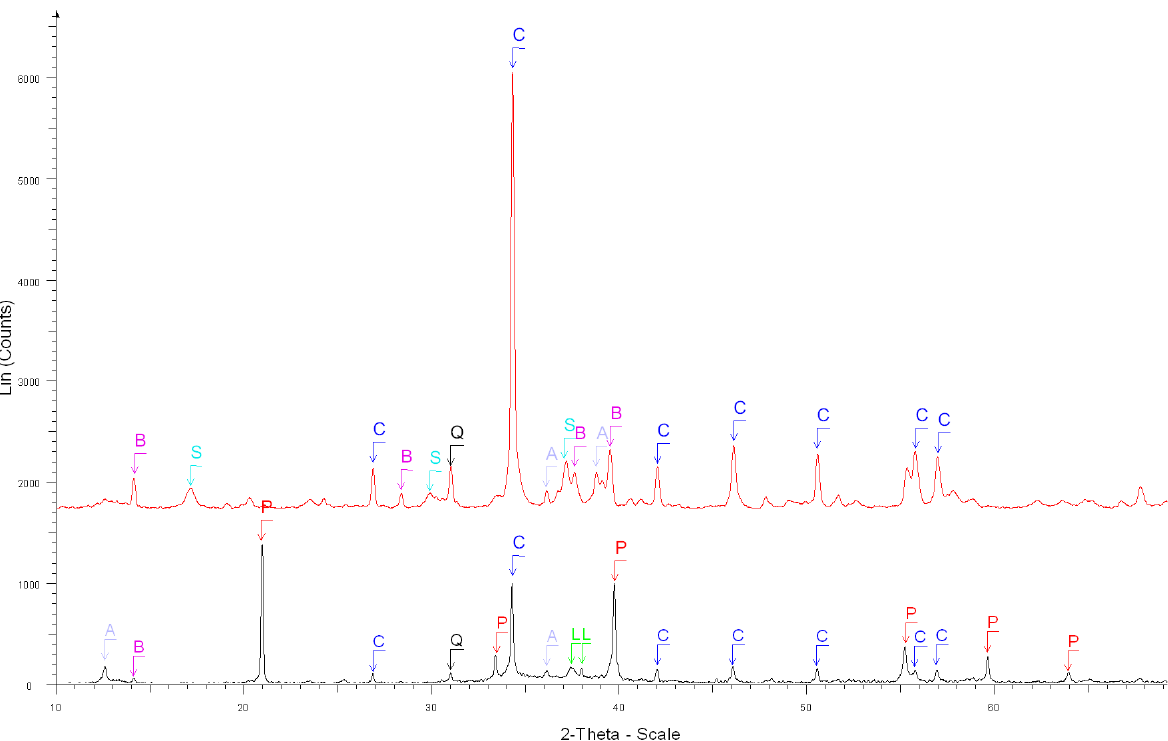
Figure 5. XRD diffractograms: Before (black curve below) and after the dissolution (red curve above) of grey cement paste. B, S, C, Q, A, P and L stand for brownmillerite, calcium sulfate hydrate, calcite, quartz, calcium aluminum oxide, portlandite and β -dicalcium silicate, respectively.